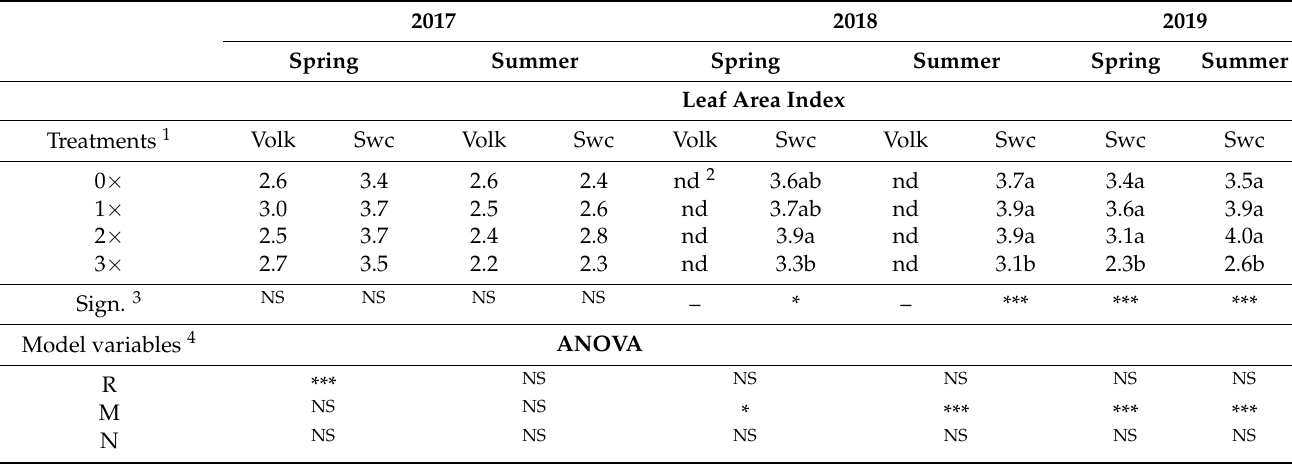
Table 4. Effect of rootstock and ground-applied plant nutrition on the leaf area index (LAI) and analysis of variance (ANOVA) of Huanglongbing (HLB)-affected citrus trees cv. “Valencia” budded on Volkameriana (Volk) or Swingle (Swc) rootstocks at Immokalee, FL during the 2017–2018 growing